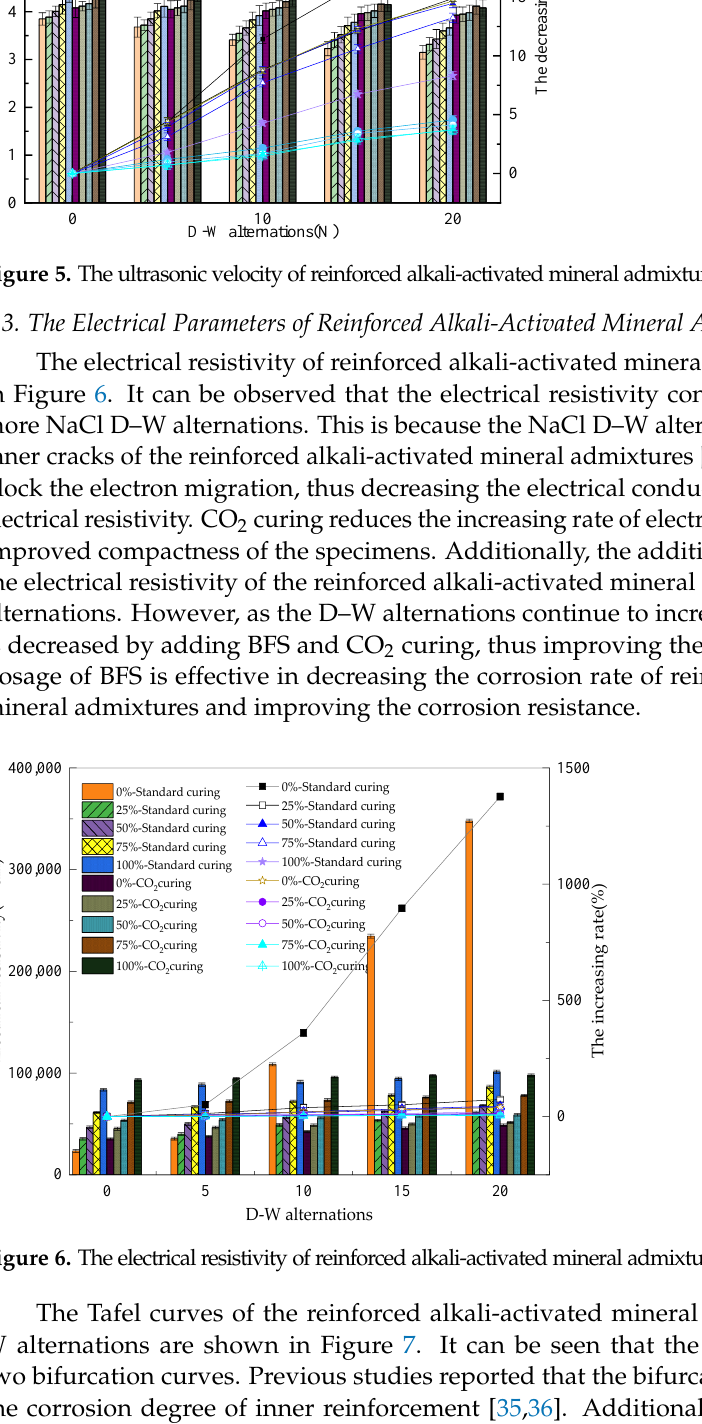
Figure 6. The electrical resistivity of reinforced alkali-activated mineral admixtures during D – W alternations.